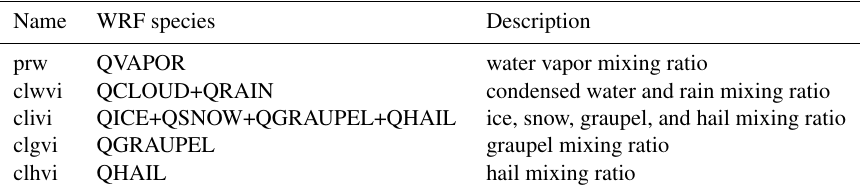
Table 3. Mixing ratio associated with column-integrated variables. Name WRF species Description prw QVAPOR water vapor mixing ratio clwvi QCLOUD+QRAIN condensed water and rain mixing ratio clivi QICE+QSNOW+QGRAUPEL+QHAIL ice, snow, graupel, and hail mixing ratio clgvi QGRAUPEL graupel mixing ratio clhvi QHAIL hail mixing